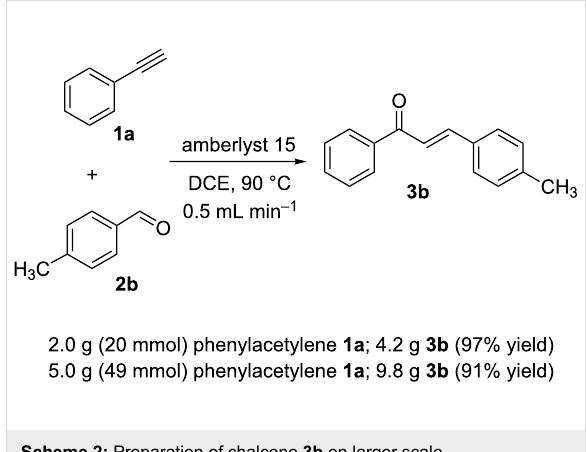
Scheme 2: Preparation of chalcone 3b on larger